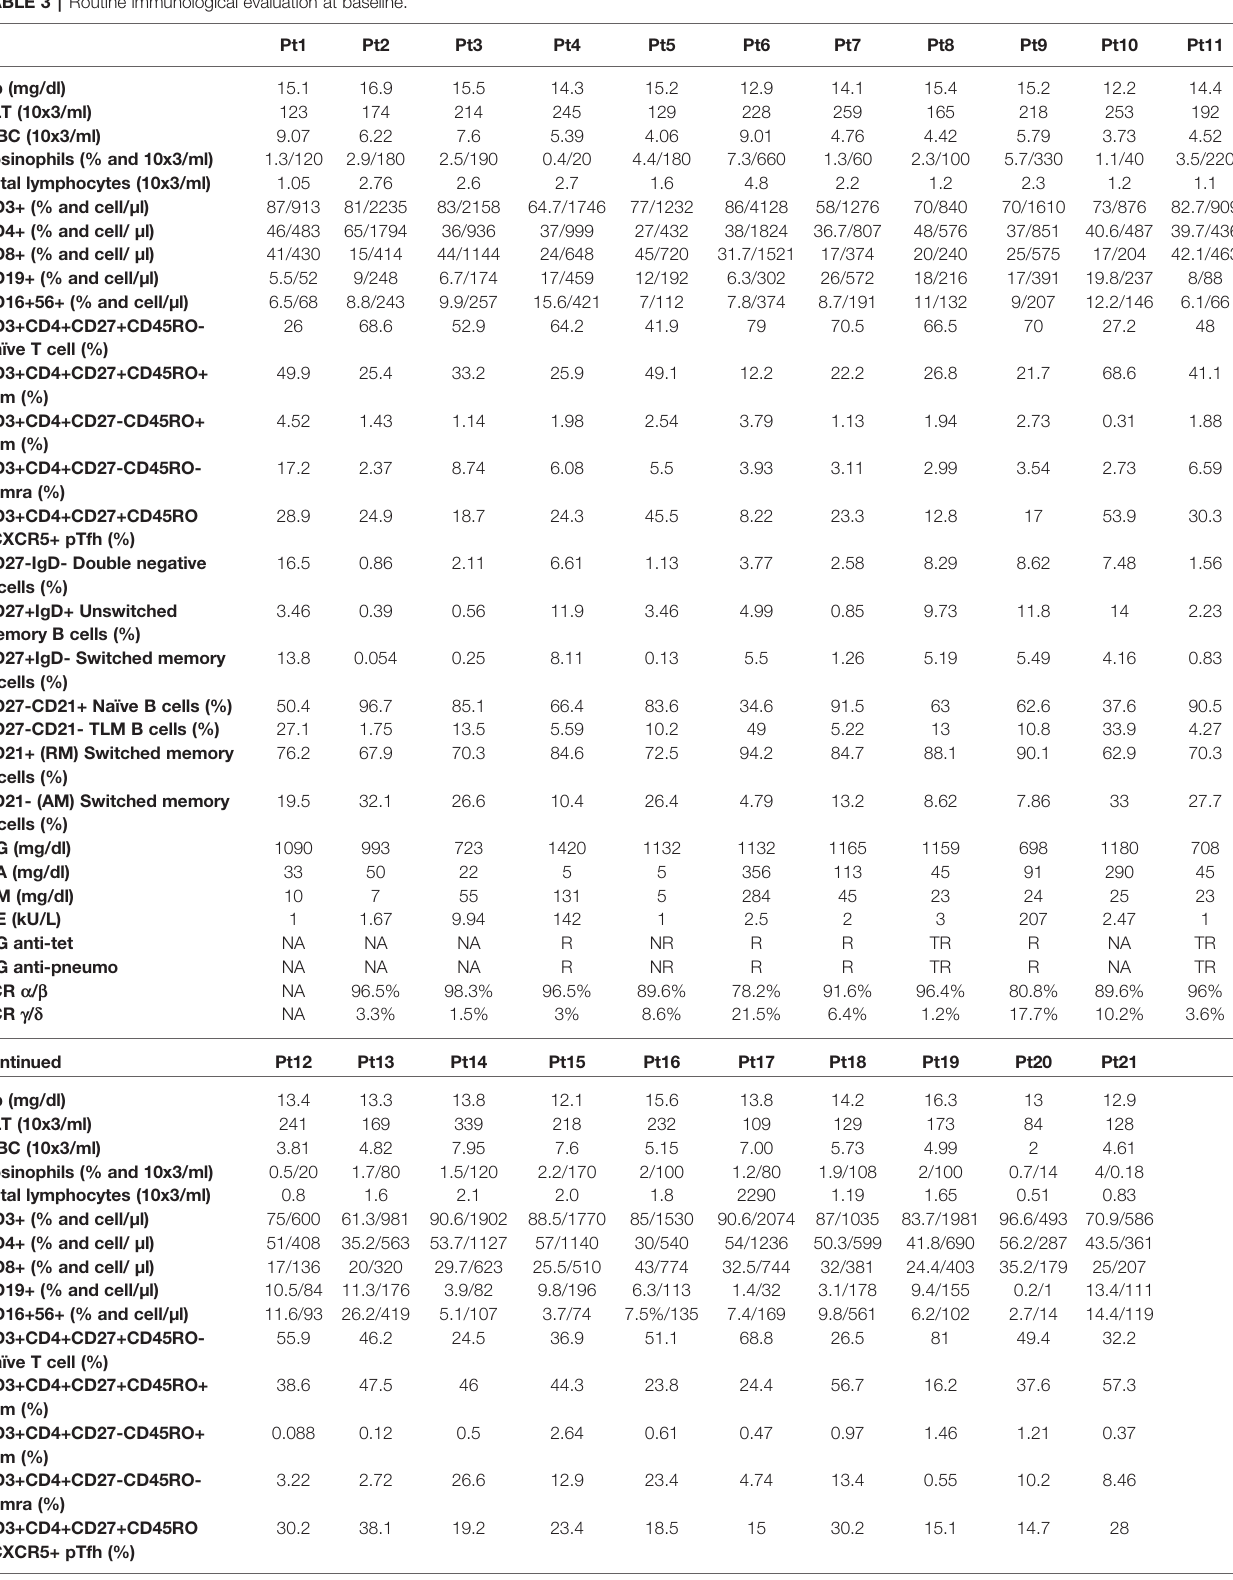
TABLE 3 | Routine immunological evaluation at